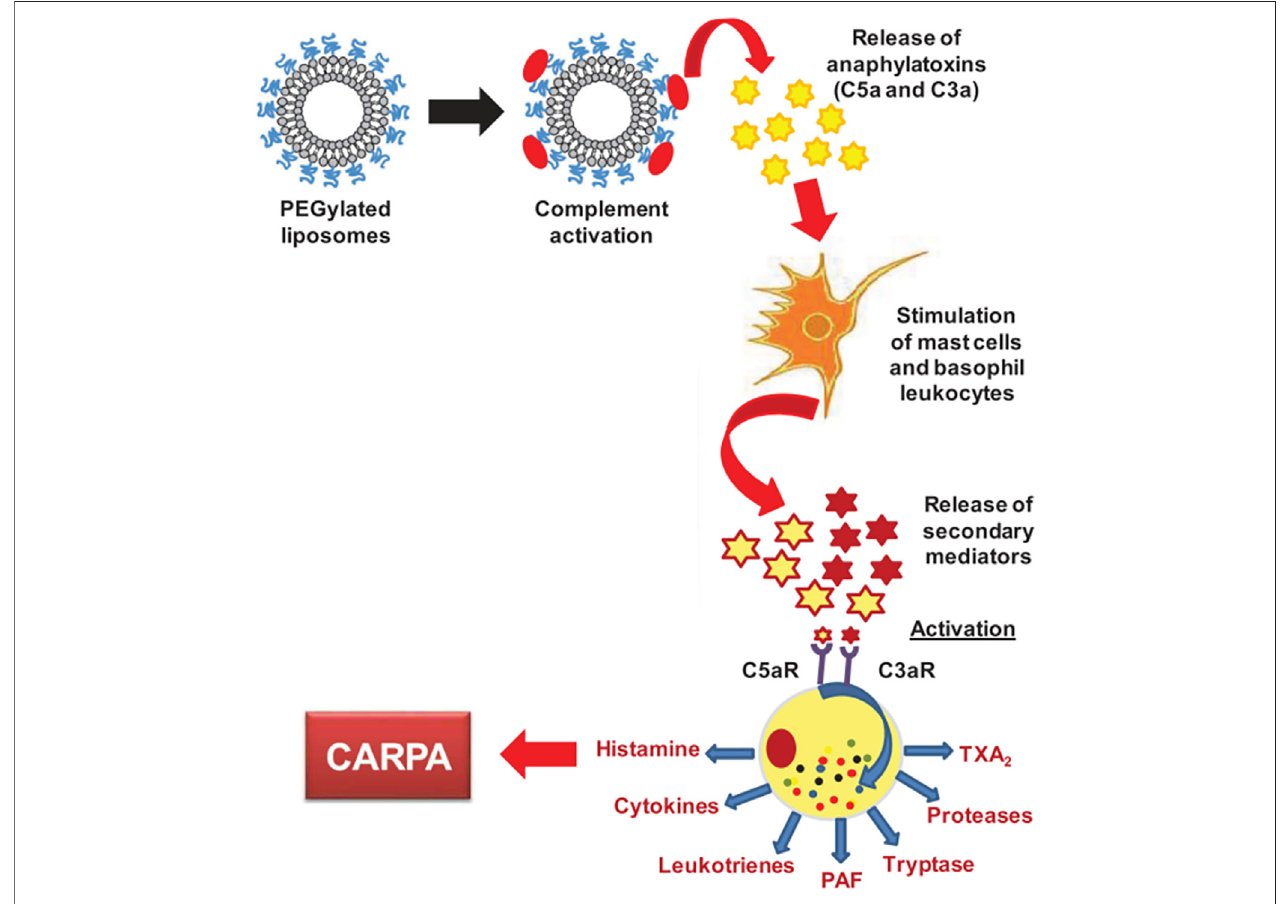
FIGURE 7 | CARPA mechanism. The fi gure is taken from ref (Mohamed et al., 2019).